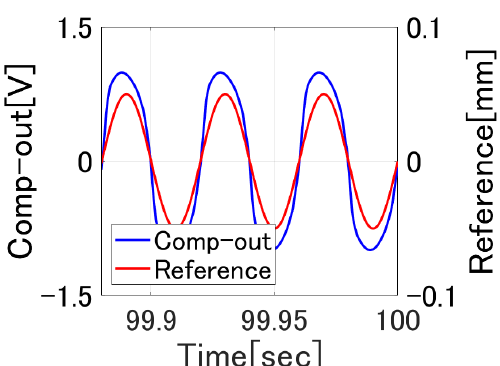
Figure 20. Control input u comp [ k ] (“Comp-out” in the legend) and the reference y d [ k ] whose frequency is 25